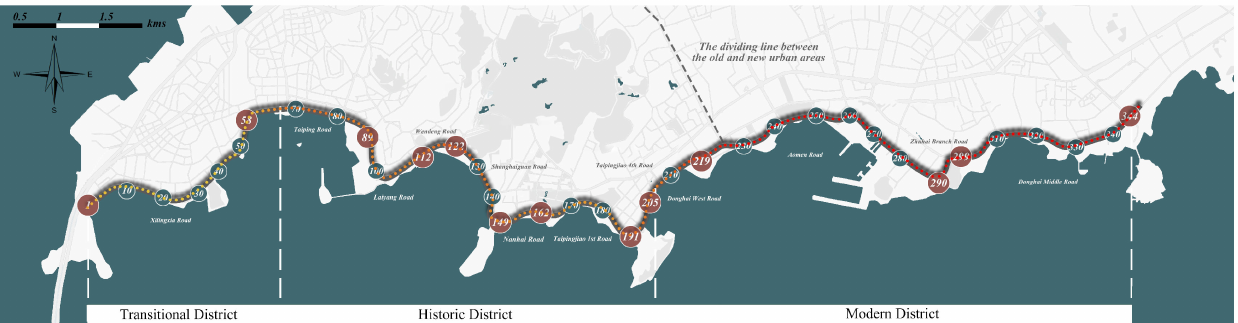
Figure 5. Three types of Qingdao Coastal